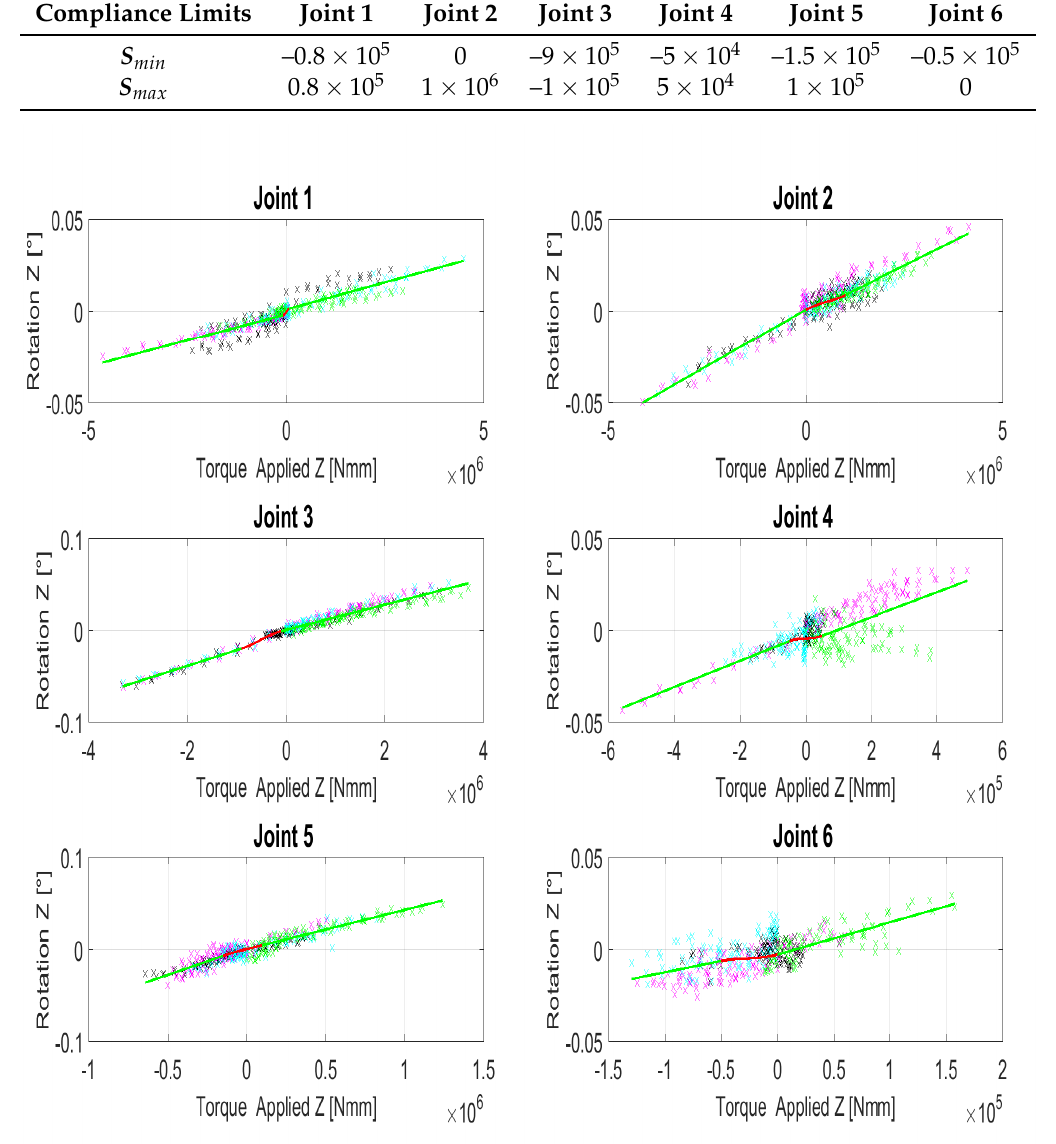
Figure 6. Joint compliance models and their nonlinear descriptions around the z -axes of all six